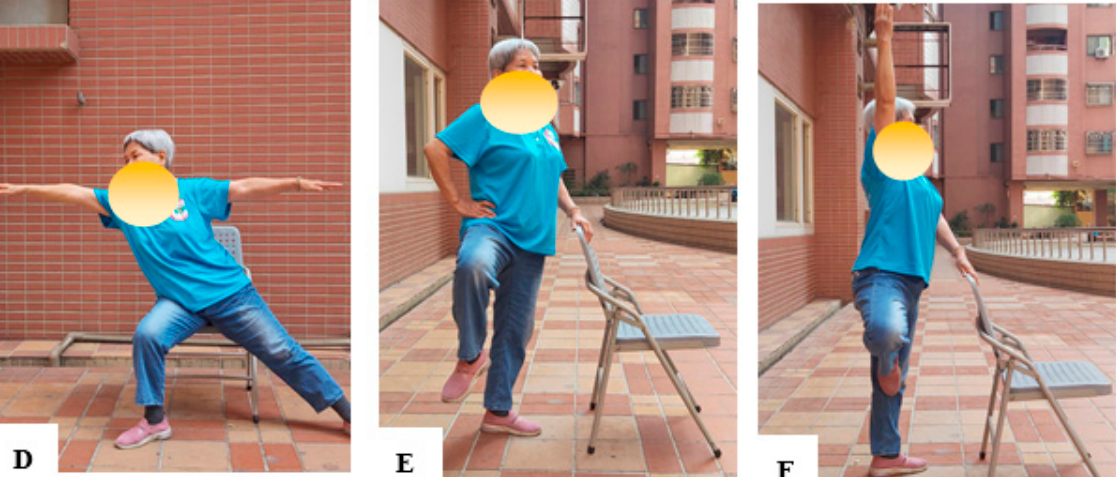
Figure 1. The various chair yoga positions performed by participants are shown in this figure. Some examples are ( A ) reaching both arms forward and waving them up and down, ( B ) seated mountain pose, ( C ) down dog with chair, ( D ) hero pose, ( E ) Lifting the knees while standing, ( F ) tree pose.